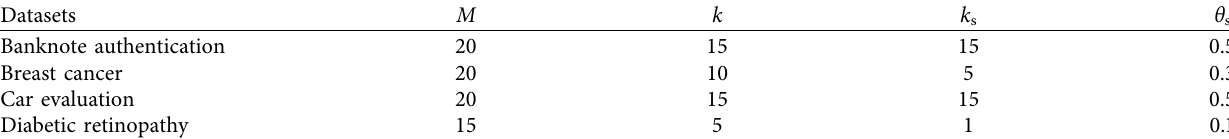
Table 4: Reasonable combination of four DNM parameters for four tested